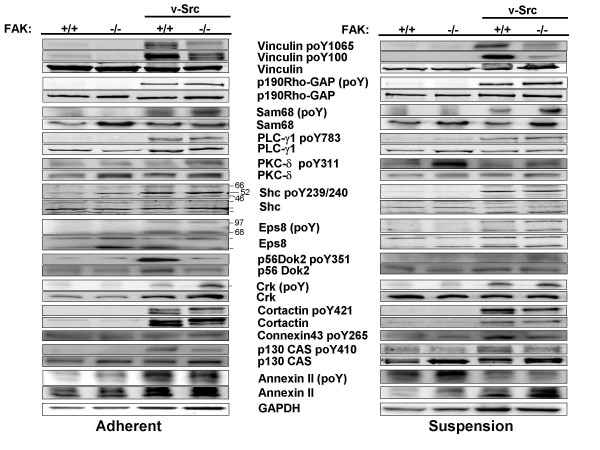
FAK and adhesion modulate v-Src-induced phosphorylation of various Src substrates. (A) Lysates from adherent cultures of FAK+/+[puro], FAK-/-[puro], FAK+/+[v-Src] and FAK-/-[v-Src] cells were probed either directly by IB for specific phosphorylated form(s) of the Src substrate proteins, total substrate protein levels or GAPDH, or probed for total phosphorylated protein by immunoprecipitating with substrate-specific Ab followed by IB for phosphotyrosine using MAb4G10. (B) Same IB or IP/IB analysis as in panel A using lysates of suspension cultures. Each of these blots is typical of at least duplicate independent experiments.